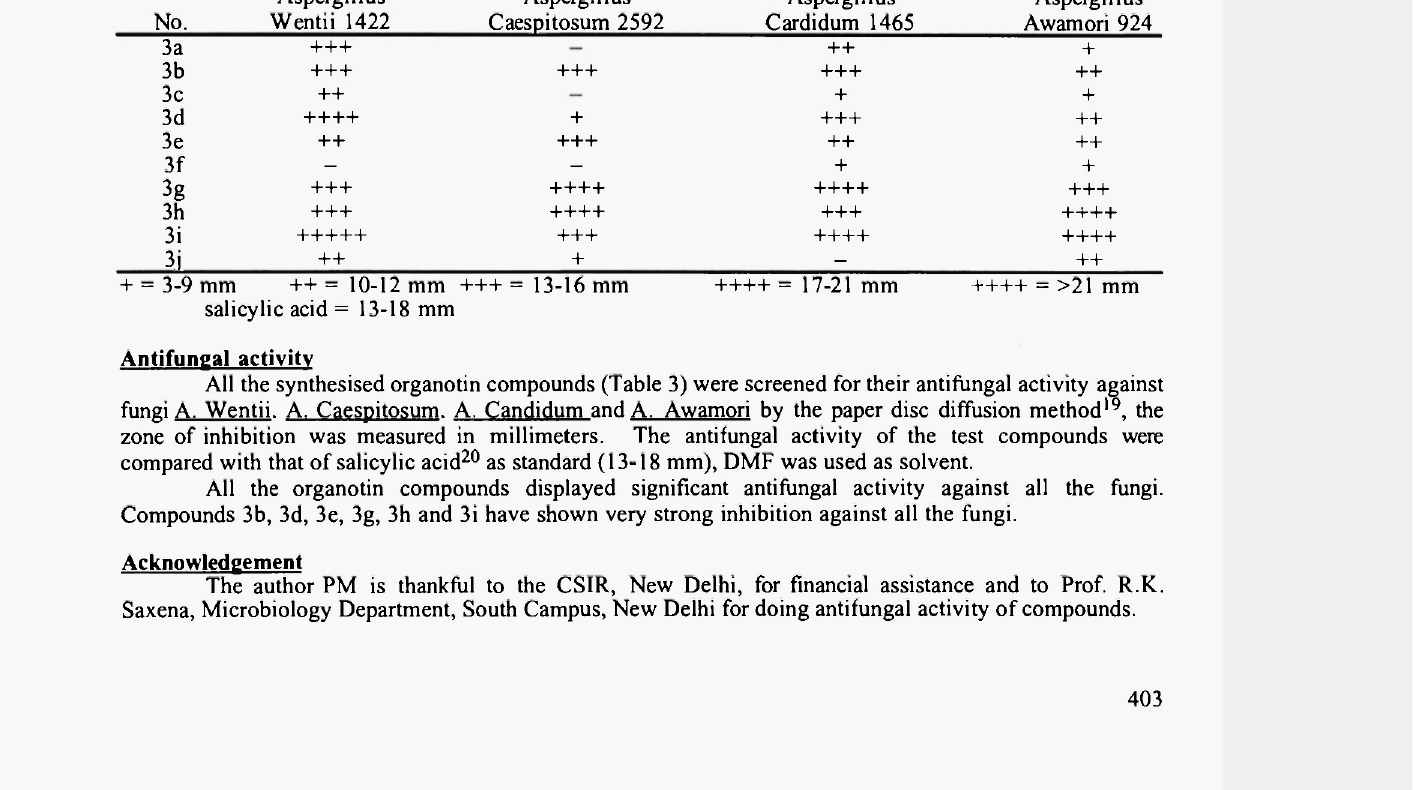
Antifungal Activity of Organotin Compounds 3a-i Compd. Inhibition